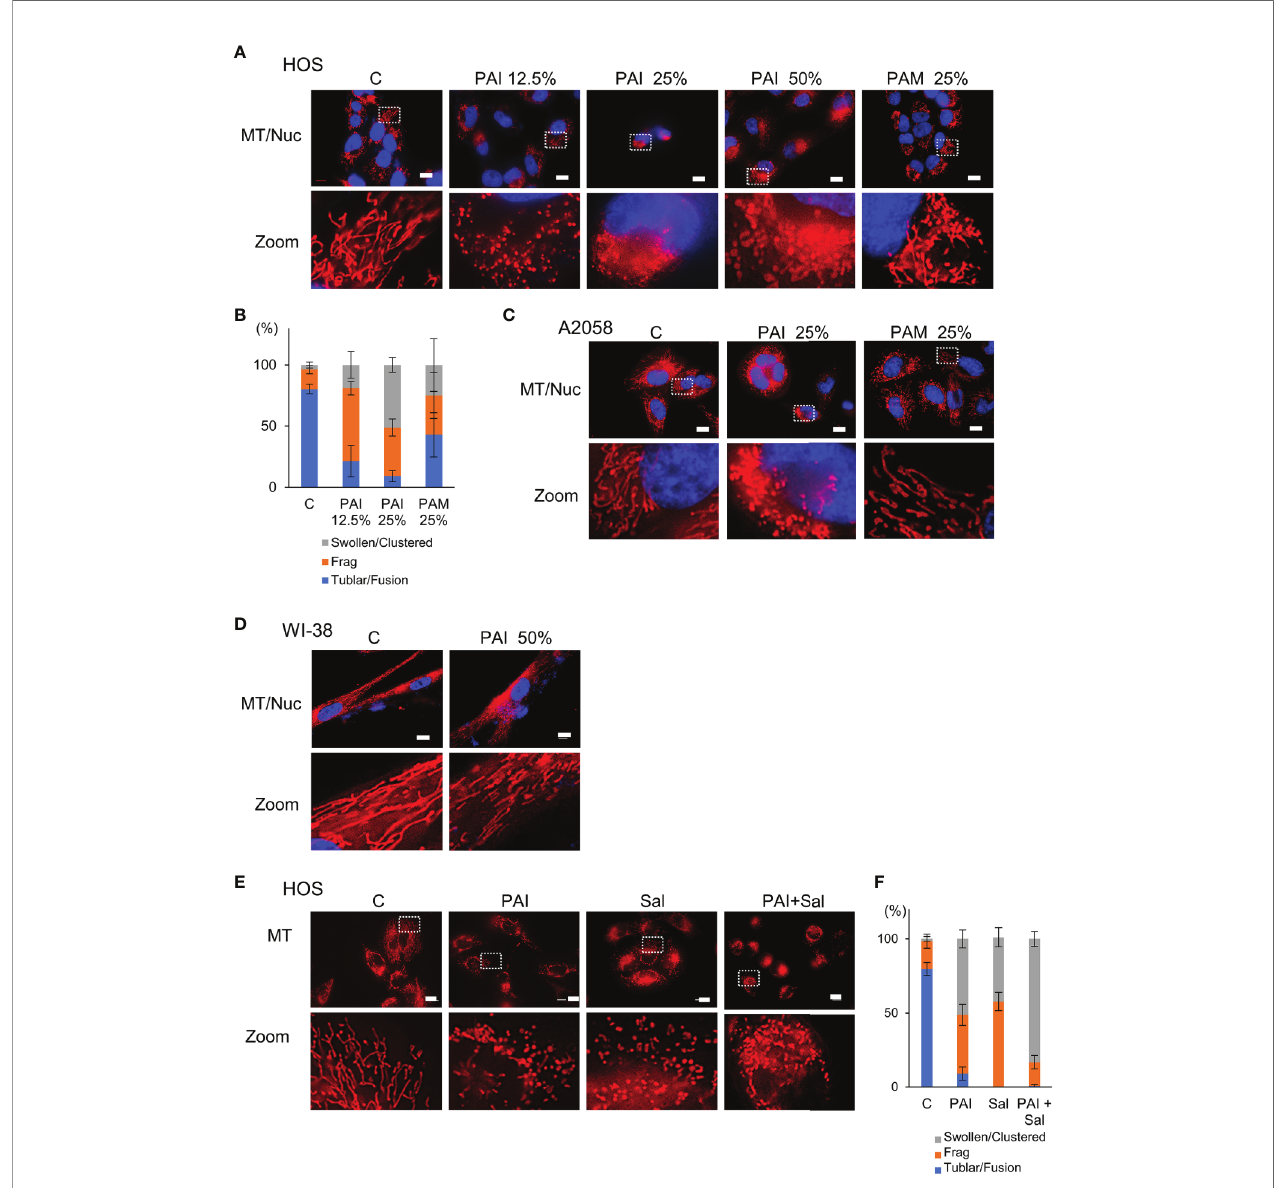
FIGURE 7 | Combined administration of PAI and Sal induces mitochondrial network collapse in a tumor-selective manner. (A, E) HOS, (C) A2058 cells, and (D) WI- 38 fi broblasts grown on coverslips were treated with PAI at the indicated concentrations and PAM (25%) (A) , with PAI (25%) and PAM (25%) (C) , with PAI (50%), (D) or with PAI (25%) and Sal (1 m M) alone or in combination (E) for 18 h. After washing, the cells were stained with MitoTracker Red CMXRos (for mitochondria, MT) for 1 h and washed again. The nuclei were counterstained with Hoechst 33342 (Nuc). Images were obtained using a BZX-710 digital biological microscope equipped with a 100×coverslip-corrected oil objective and were analyzed using BZ-H3A application software. Zoom images represent the magni fi cation of the representative images in the box. Bar = 10 m m. (B, F) Quantitative analysis of mitochondrial morphology in the cells. For each sample, the morphology of mitochondria in 30~60 cells was analyzed, and the percentages of four different types, i.e., tubular/fused, fragmented, and swollen/clustered, were calculated. Data in six independent experiments were analyzed by one-way analysis of variance followed by Tukey ’ s post hoc test. Results are shown as mean ±